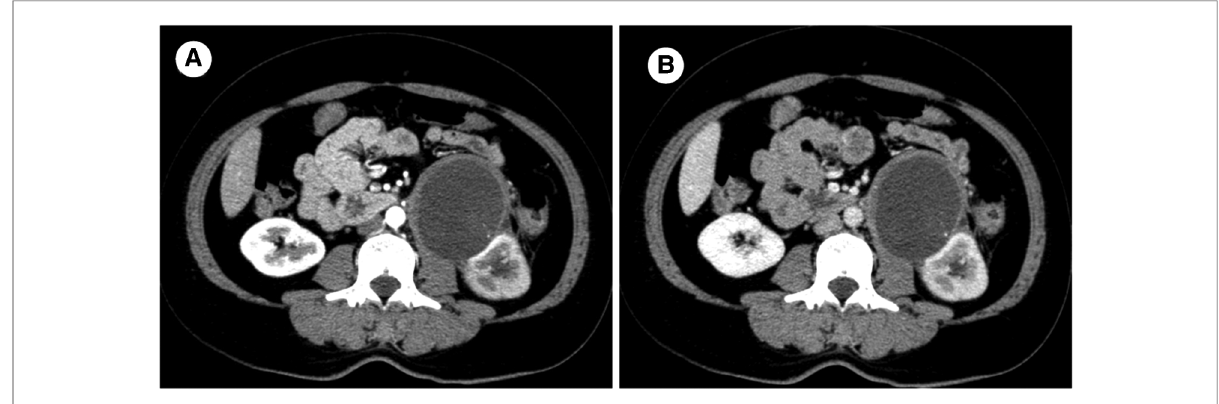
FIGURE 1 Enhanced computed tomography scan: A round low-denisty cystic mass located at the renal helium, measuring 7.4×7.4 cm in size with a width of 0.5 cm at the wall. ( A ) Arterial phase ( B ) Venous